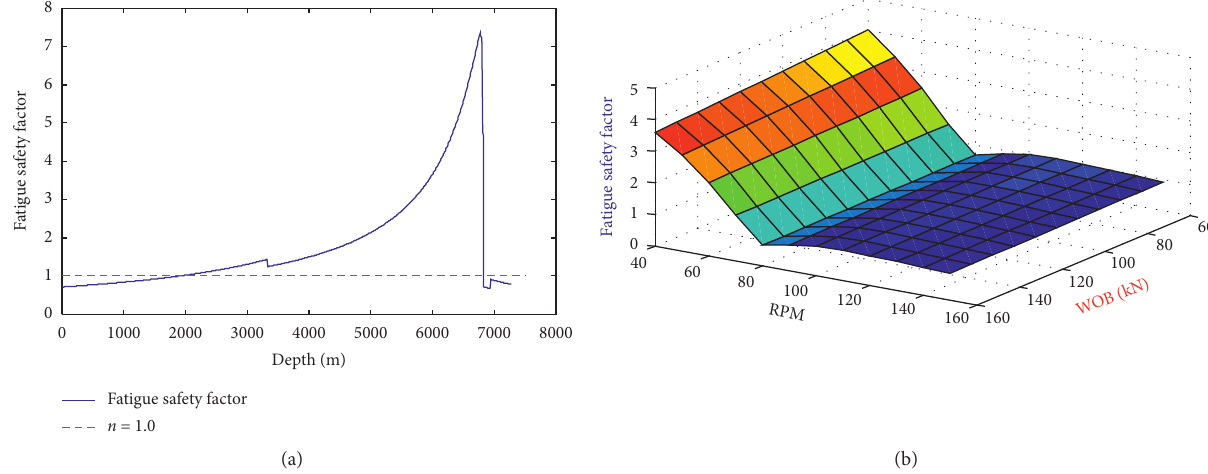
Figure 10: (a) Safety factor diagram of drilling tool. (b) Safety factor of connection point between weighted drill pipe and drill collar (WOB: 60–160kN; RPM: